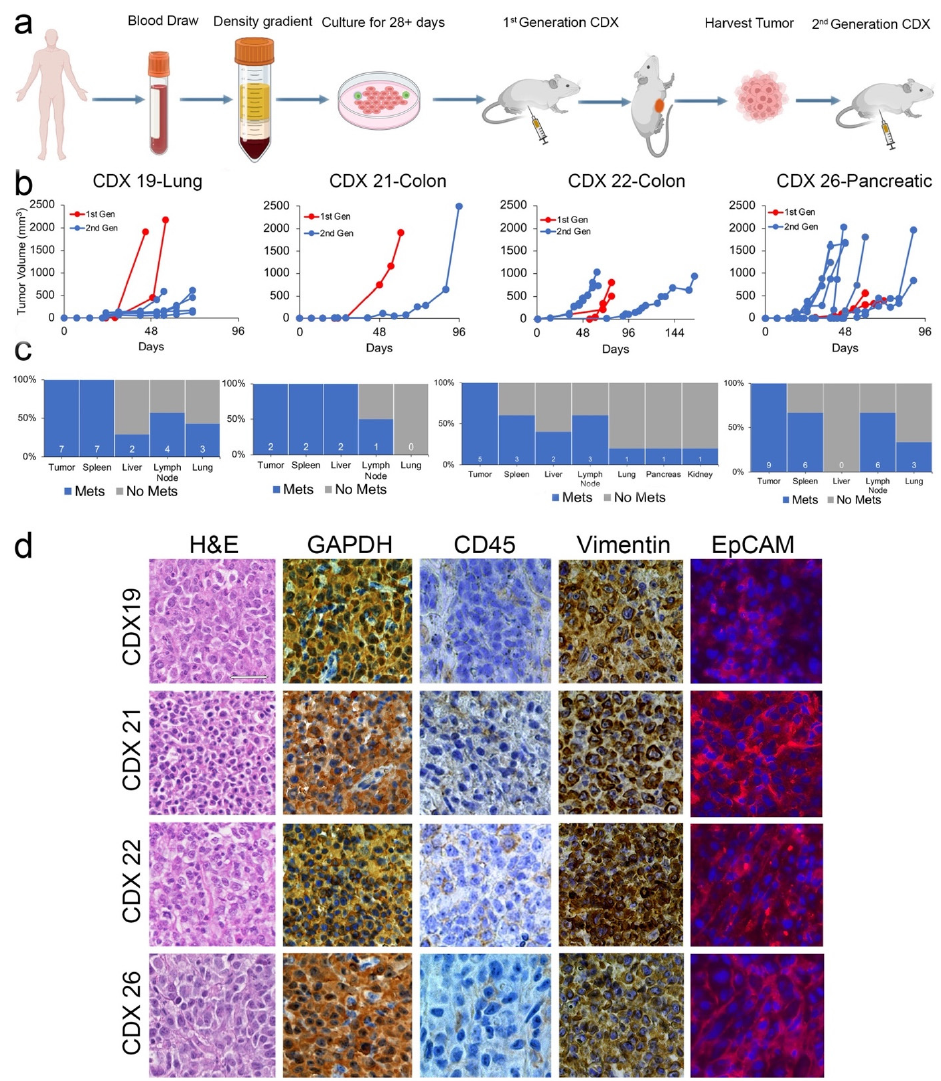
Figure 2. Four patient-derived CDX models were established following a period of short-term CTC culture. ( a ) Schema of CDX model formation created using Biorender.com. ( b ) Growth charts indi- cating the progression of CDX tumors. The first-generation CDX models were established via the injection of cultured CTCs; the second-generation CDX models were established via the serial re- engraftment of tissue derived from the first-generation CDX primary tumors. ( c ) Corresponding bar graphs indicating the number of CDX models with evidence of tumors in distant organs, separated by patient. ( d ) Representative hematoxylin & eosin (H&E, column 1), DAB chromogen staining of human-specific GAPDH (column 2), common leukocyte marker CD45 (column 3), and vimentin (column 4), and immunofluorescence staining for EpCAM was performed on first-generation CDX primary tumors. Scale bar = 25 um. CDX: CTC-derived xenograft .